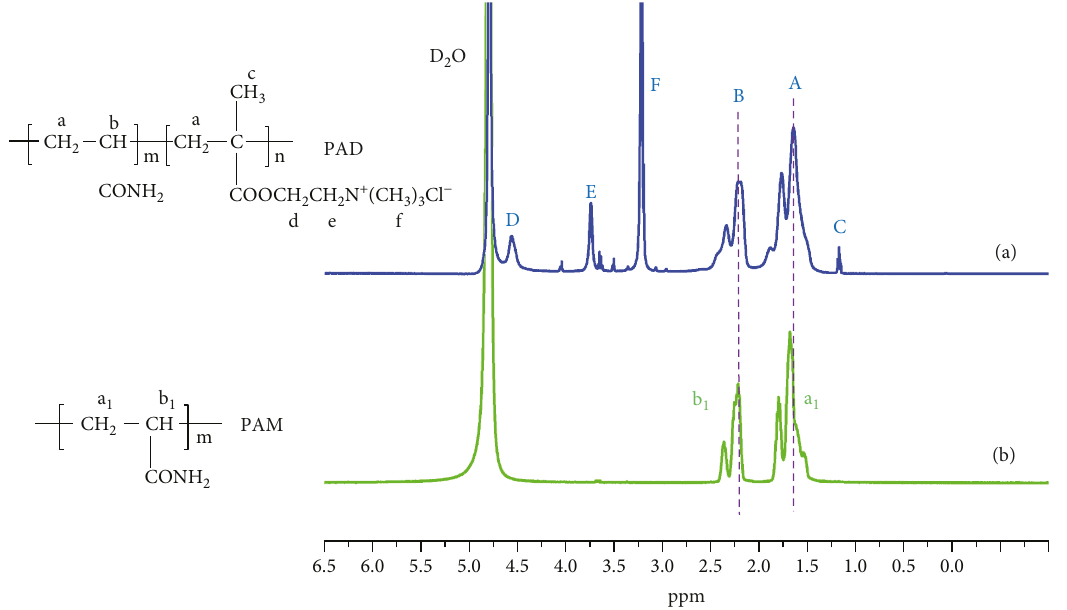
Figure 10: 1 H NMR spectra of (a) PAD and (b)